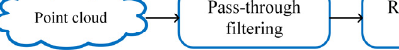
Figure 2. Process of point cloud filtering.